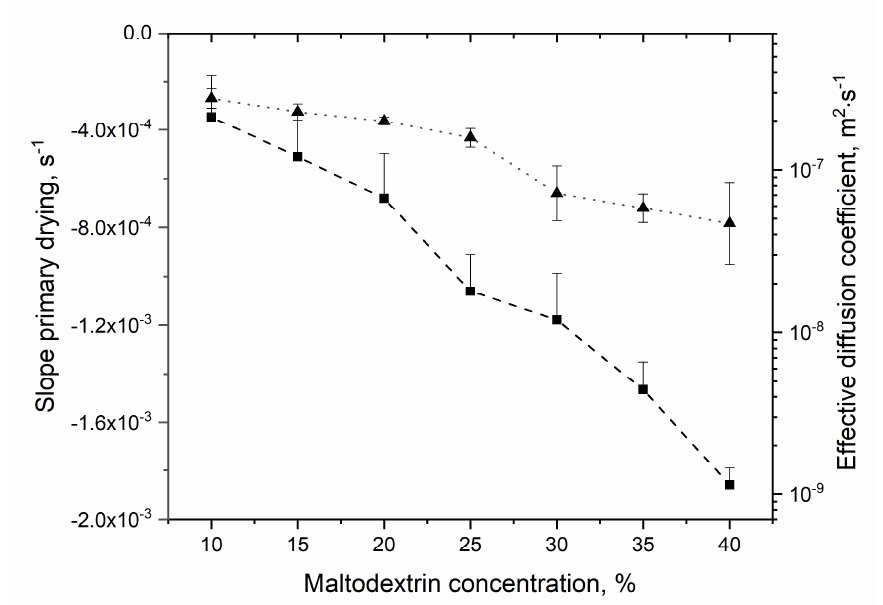
Figure 3. E ff ective di ff usion coe ffi cient ( (cid:4) ) and slope of the primary drying section ( (cid:78) ) as a function of the maltodextrin concentration of microwave-supported freeze-drying (MWFD) dried